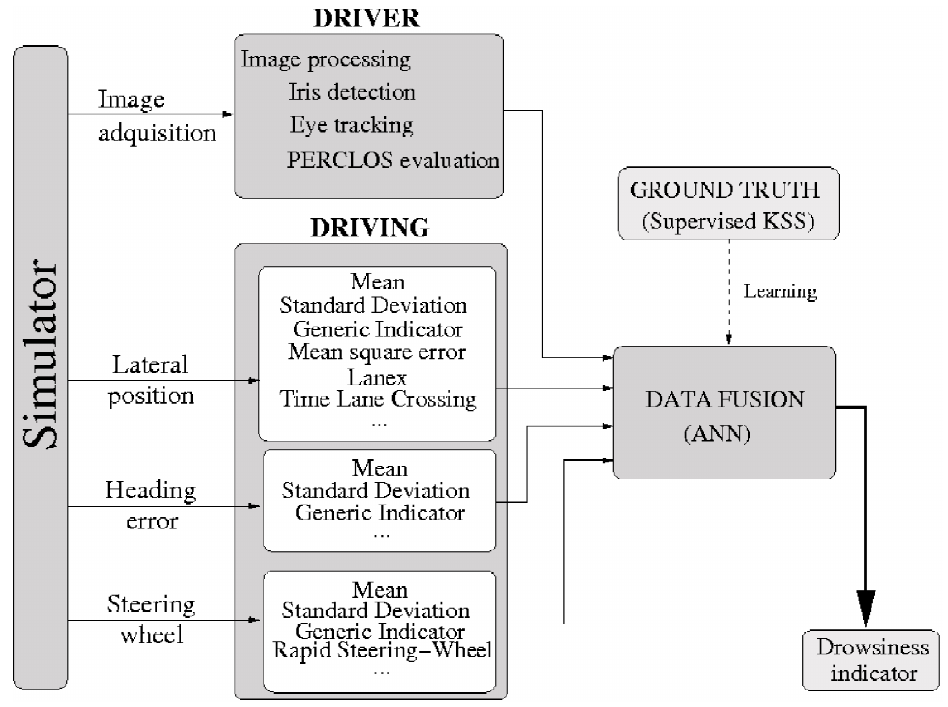
Figure 2. General architecture of our Drowsiness Detection